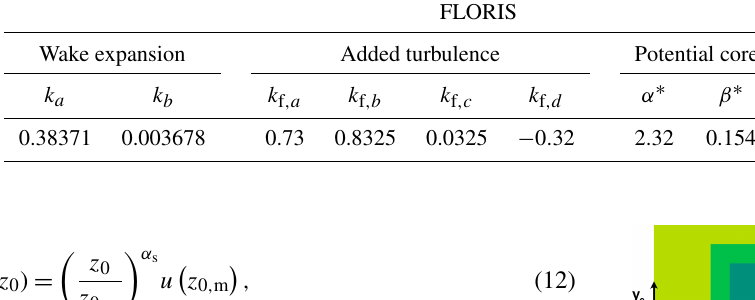
Table 1. Parameters used in the simulation with the values they influence. FLORIS FLORIDyn Wind Wake expansion Added turbulence Potential core Power chains, OPs shear